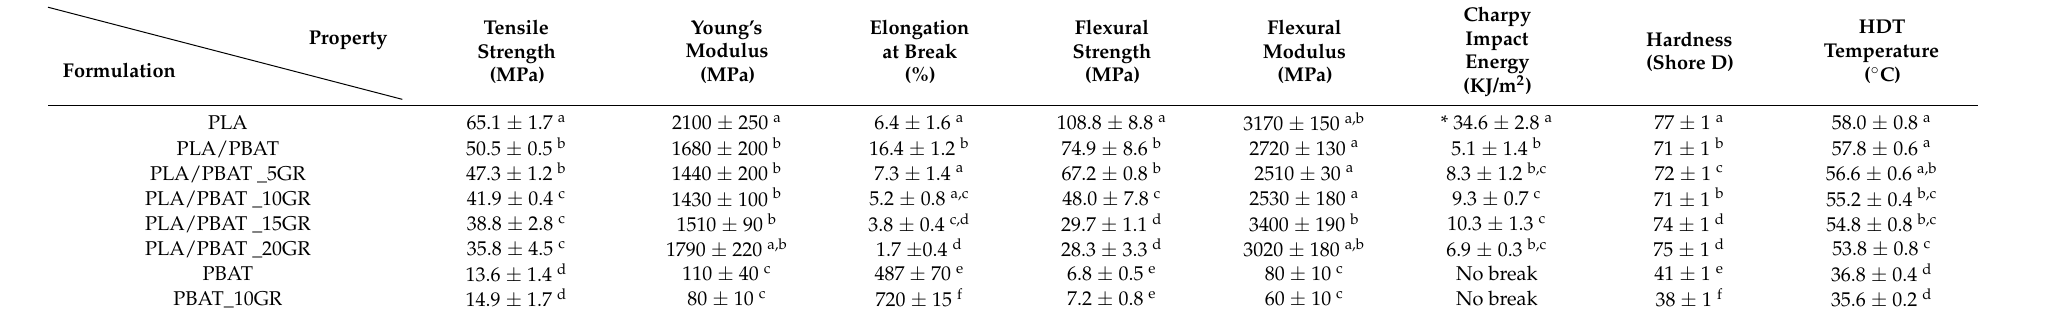
Table 3. Mechanical properties of PLA/PBAT blends with different contents of gum rosin (GR) as